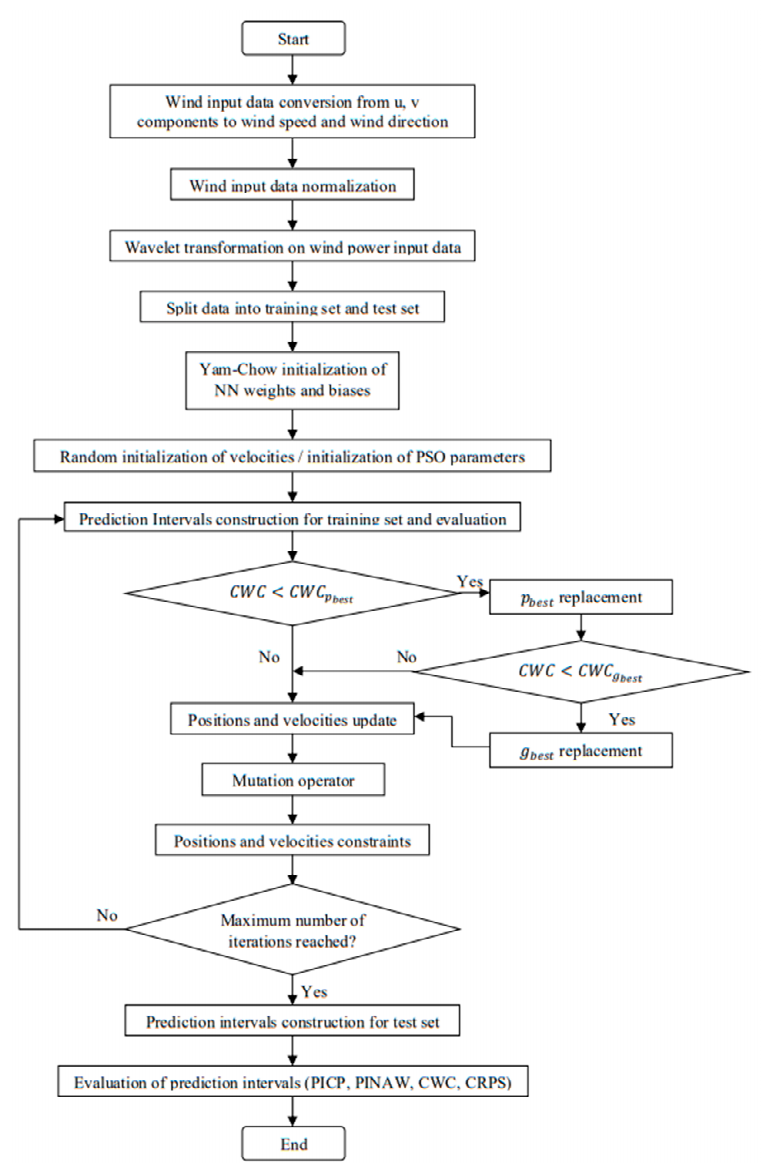
Figure 5. Flow chart of the proposed WT-LUBE-PSO-CWC methodology. More specifically, for each one of the two zones researched, the dataset is randomly split into a training set and a test set. Of the data, 75% are used for the training process and the remaining 25% used for testing. The training set is split into sub-training sets and validation sets via the five-fold cross validation method. The five-fold cross validation is further implemented into the PSO algorithm to estimate the optimal number of particles. A wavelet function of type Daubechies of order 4 is implemented to analyze the wind power data for each component in order to simplify the preprocessing of the wind power database. The initialization process deals with NN and PSO parameter initialization. An op- timal initialization of the NN weights leads to better and more accurate results for the forecasting model. The Yam-Chow initialization method is adopted in this work in order